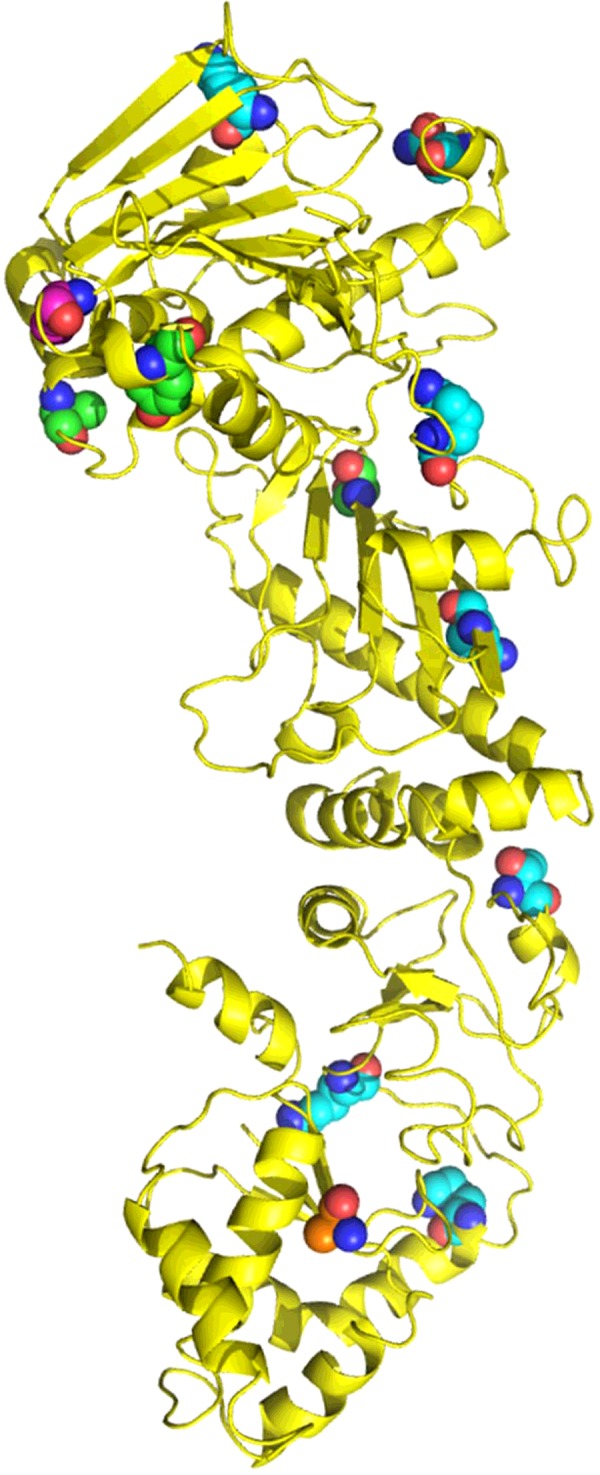
Post-translational modification of Hsp90A single monomer of yeast Hsp90 (yellow) is shown in cartoon format. Amino acid residues from yeast and human Hsp90 that are post-translationally modified are shown as spheres and mapped to the correct location on yeast Hsp90. Modified amino acid residues for Hsp90α Ser5, Ser7 and Ser234 and Thr725 and Hsp90β Ser255 that are not represented in the yeast structure are omitted. Green spheres, amino acids that are phosphorylated; cyan spheres, amino acids that are acetylated, magenta spheres, amino acids that are SUMOylated; gold spheres, amino acids that are nitrosylated.